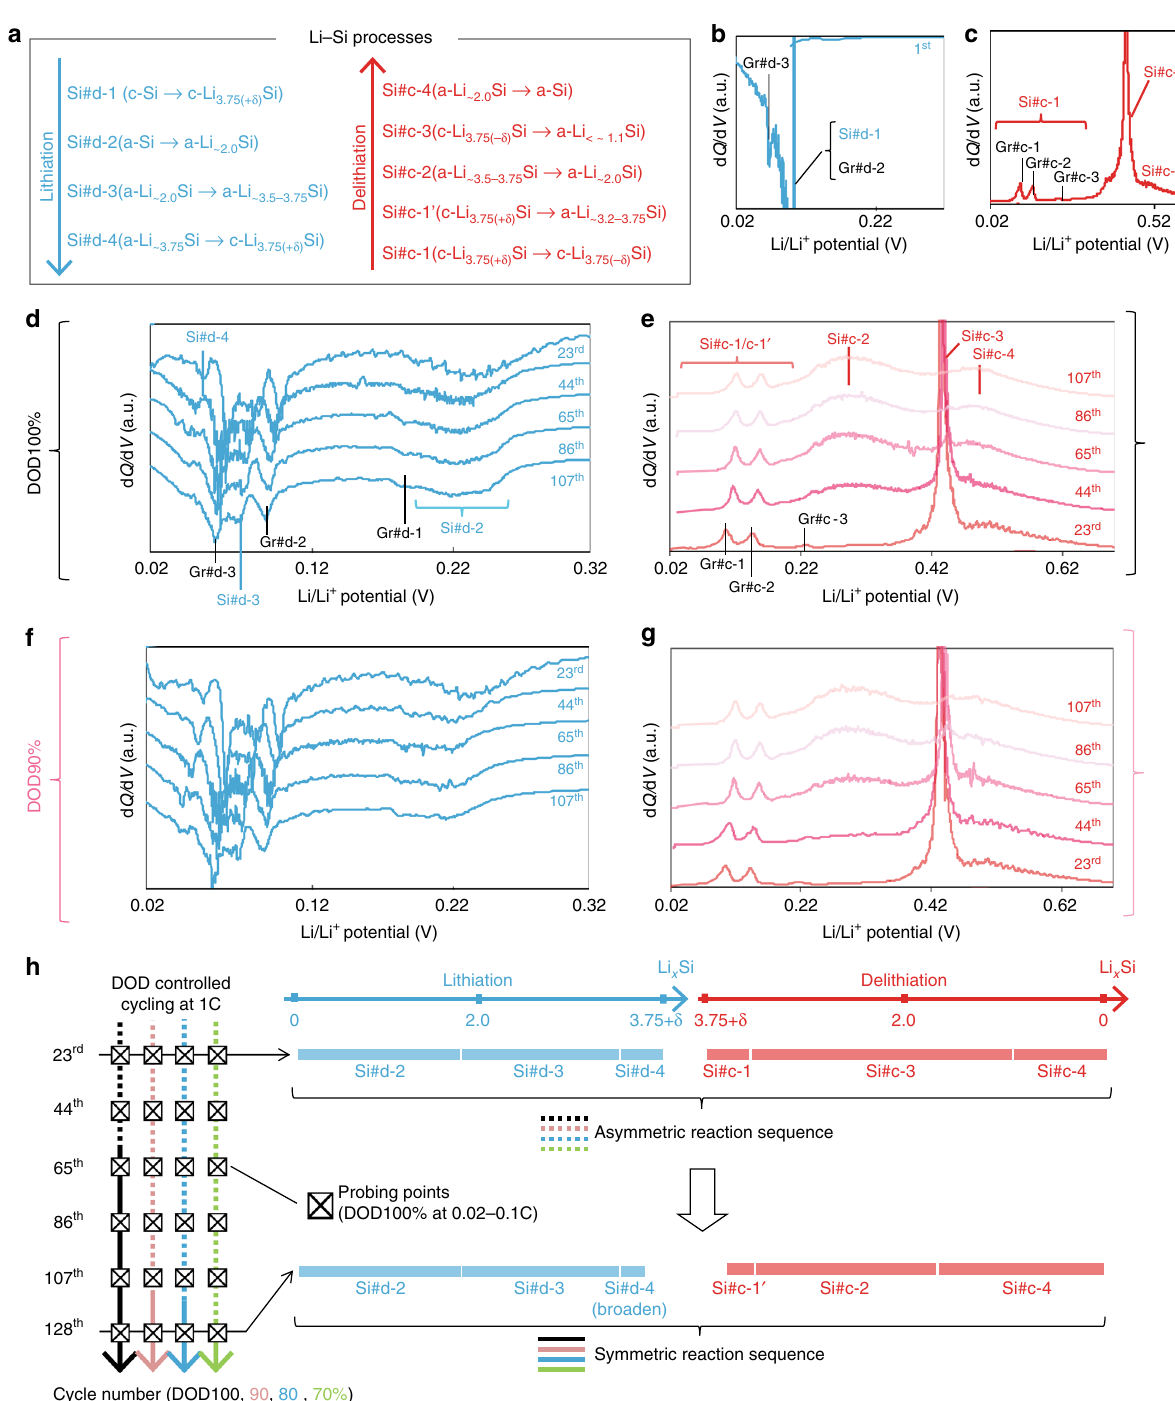
Cycle number (DOD100, 90, 80 , 70%) Fig. 3 Evolution of Li – Si electrochemical processes over cycling under different DOD controls. a Notation of the stoichiometric Li – Si electrochemical processes on (de)lithiation. Si#d-X and Si#c-X are Li – Si processes, while #d-X and #c-X denote the X th discharge (lithiation) and charge (delithiation) processes in the half-cells, respectively. For corresponding Gr#d-X and Gr#c-X processes, see Supplementary Fig. 3. The notations are also summarized in Methods (under “ Reference electrochemistry ” ) and Supplementary Table 5. d Q /d V pro fi les for type-A electrodes in the fi rst ( b ) lithiation (discharge) and ( c ) delithiation (charge). d Q /d V pro fi les at the probing points (every 20 cycles at 0.1 C under DOD100%) on ( d , f ) lithiation and ( e , g ) delithiation for ( d , e ) DOD100% and ( f , g ) DOD90%, respectively. The d Q /d V pro fi les are stacked with a constant pitch to show the different processes more clearly. h Schematics of change in the electrochemical Li – Si process fl ow at the probing points during (de)lithiation over cycling under different DOD controls. The stoichiometry of each process is indicated by the length of each bar on lithiation (blue bars) and delithiation (red bars) as a function of Li concentration in Li x Si. The reaction fl ow in the earlier cycling stage is asymmetric (dotted lines), while that in the later stage is symmetric (solid lines). The transition from the asymmetric to symmetric regimes is clearly accelerated by undergoing DOD100% protocol. The corresponding data for type-B electrode are shown in Supplementary Fig. 4 with the same tendency as in